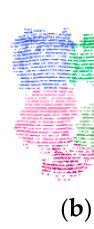
Figure 6. An example of the improved NCut segmentation algorithm: ( a ) a cluster containing multiple overlapped trees and ( b ) improved NCut segmentation results (different colors representing different single trees).